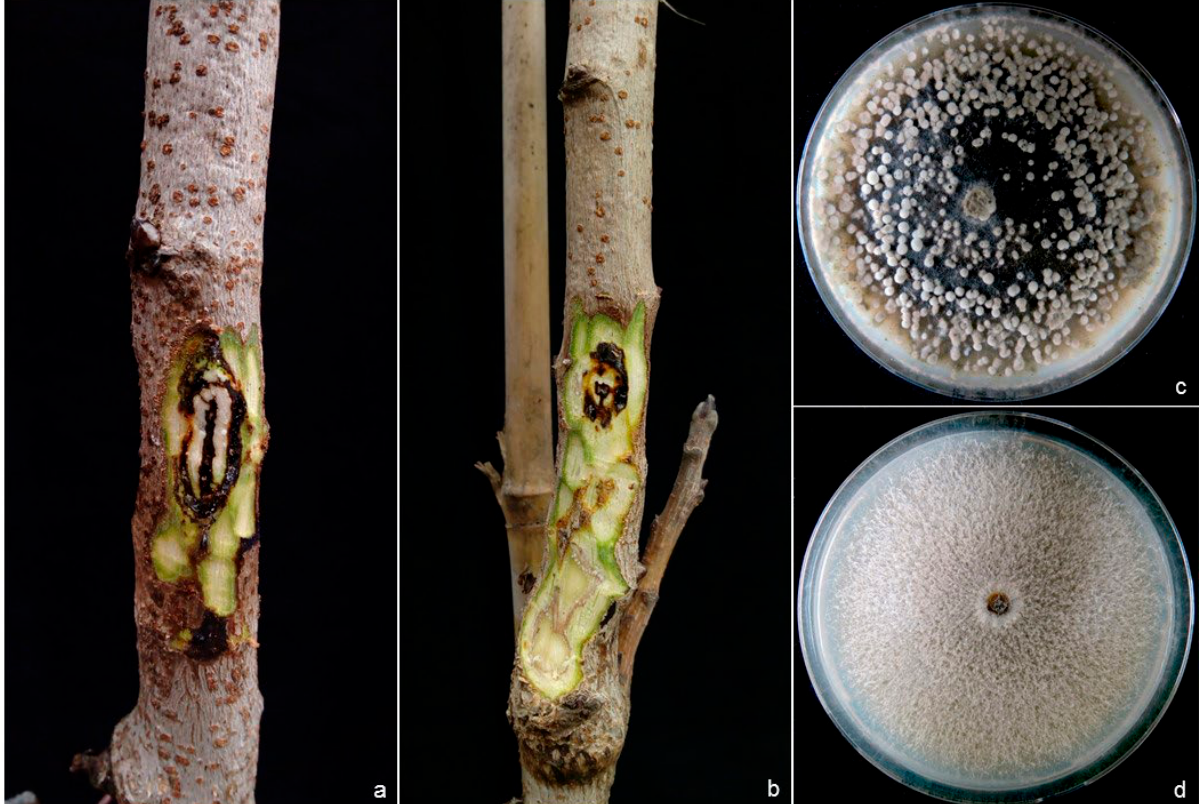
Figure 1. Symptoms reproduced from mycelial plug inoculation with Cytospora pistaciae (a) and Eutypa lata (b) on 5-y-old potted plants of Pistacia vera 5 months after inoculation with respective fungi. Cultural characteristics of Cytospora pistaciae (c) and Eutypa lata (d) colonies grown on PDA are also